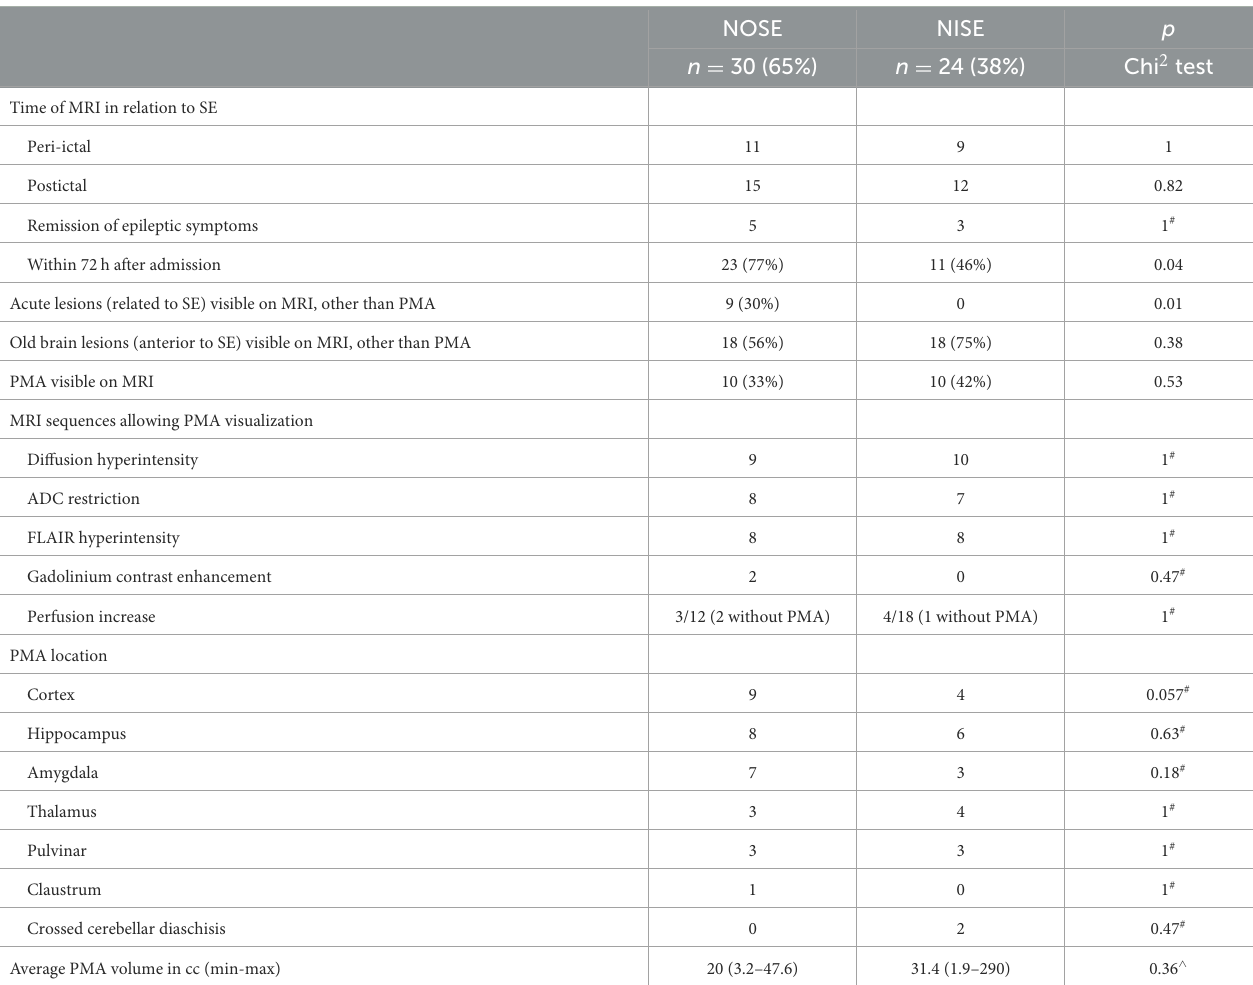
TABLE 2 MRI results in NOSE and NISE